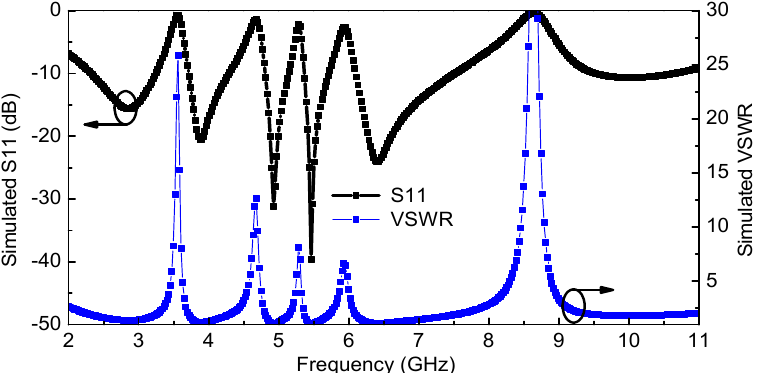
Figure 4. Simulated reflection coefficient and VSWR (Voltage Standing Wave Ratio) of the proposed quintuple band-notched UWB antenna.